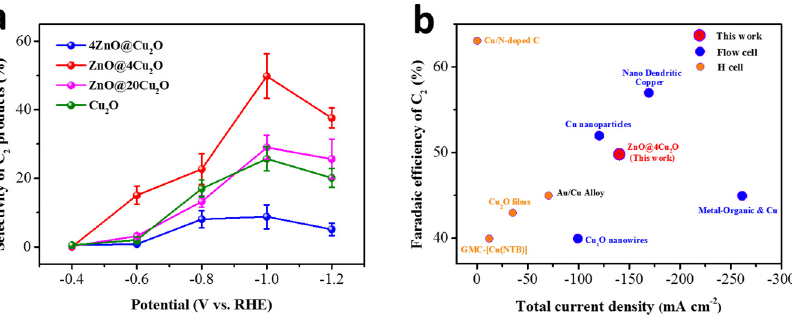
Figure 7. ( a ) Selectivity towards C 2 products on xZnO@Cu 2 O catalysts with different shell thickness. ( b ) The comparison of total current density and selectivity of C 2 products between this work with others.